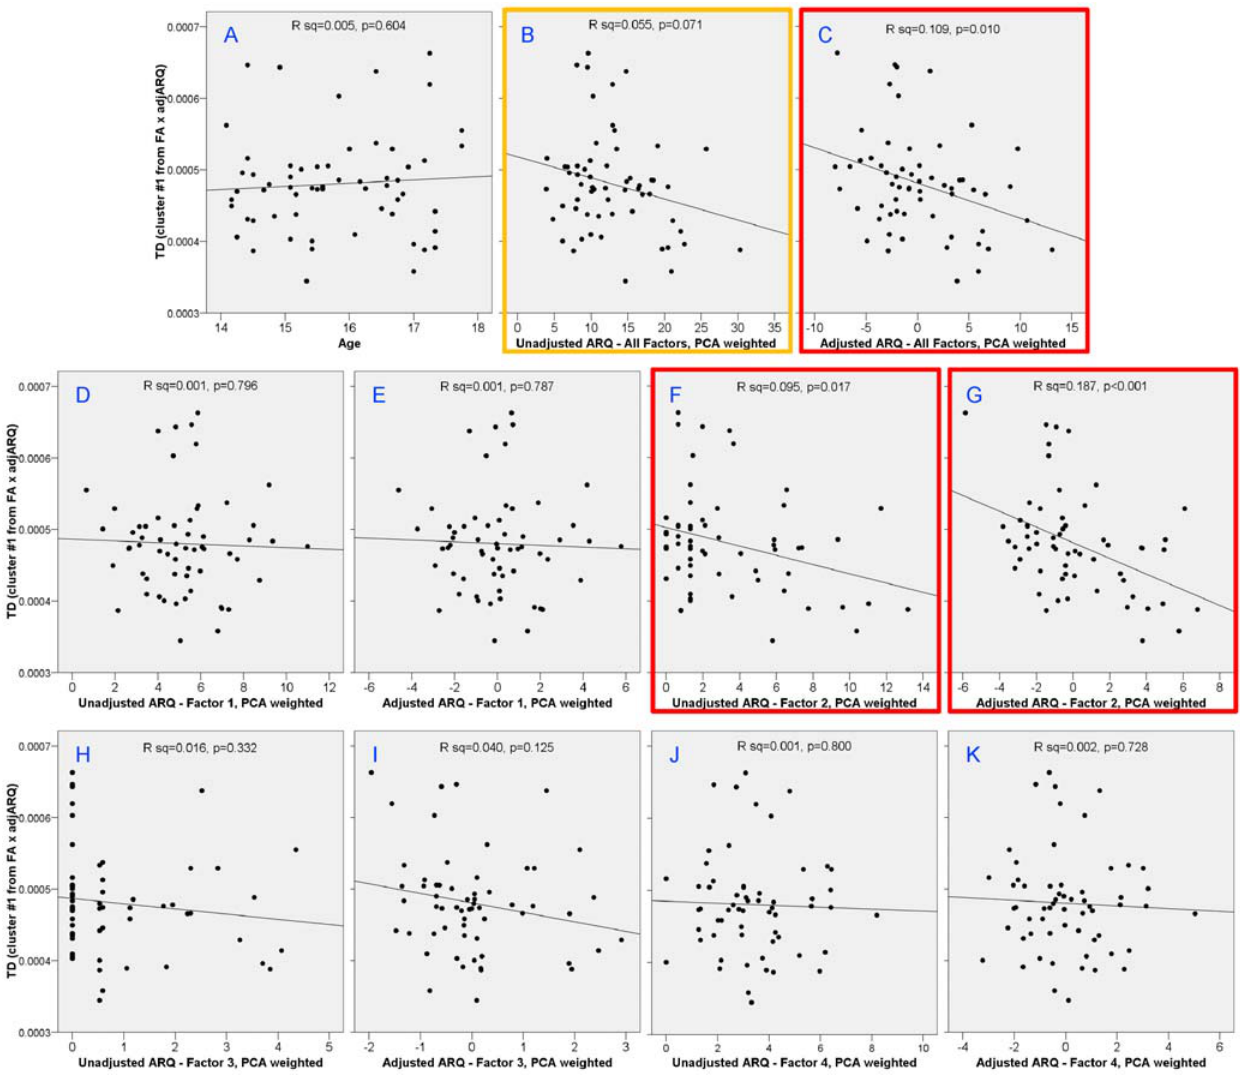
Figure 6. Correlations with TD in right superior corona radiata cluster with age and different factors of the ARQ. Age was uncorrelated with TD in this region (A). Total ARQ was significantly correlated with TD after adjusting ARQ for sex and age (C) and with a trend toward signficance in the unadjusted total ARQ (B). Analysis of the subfactors showed that this correlation was driven predominately by factor 2 – rebelliousness (F and G).